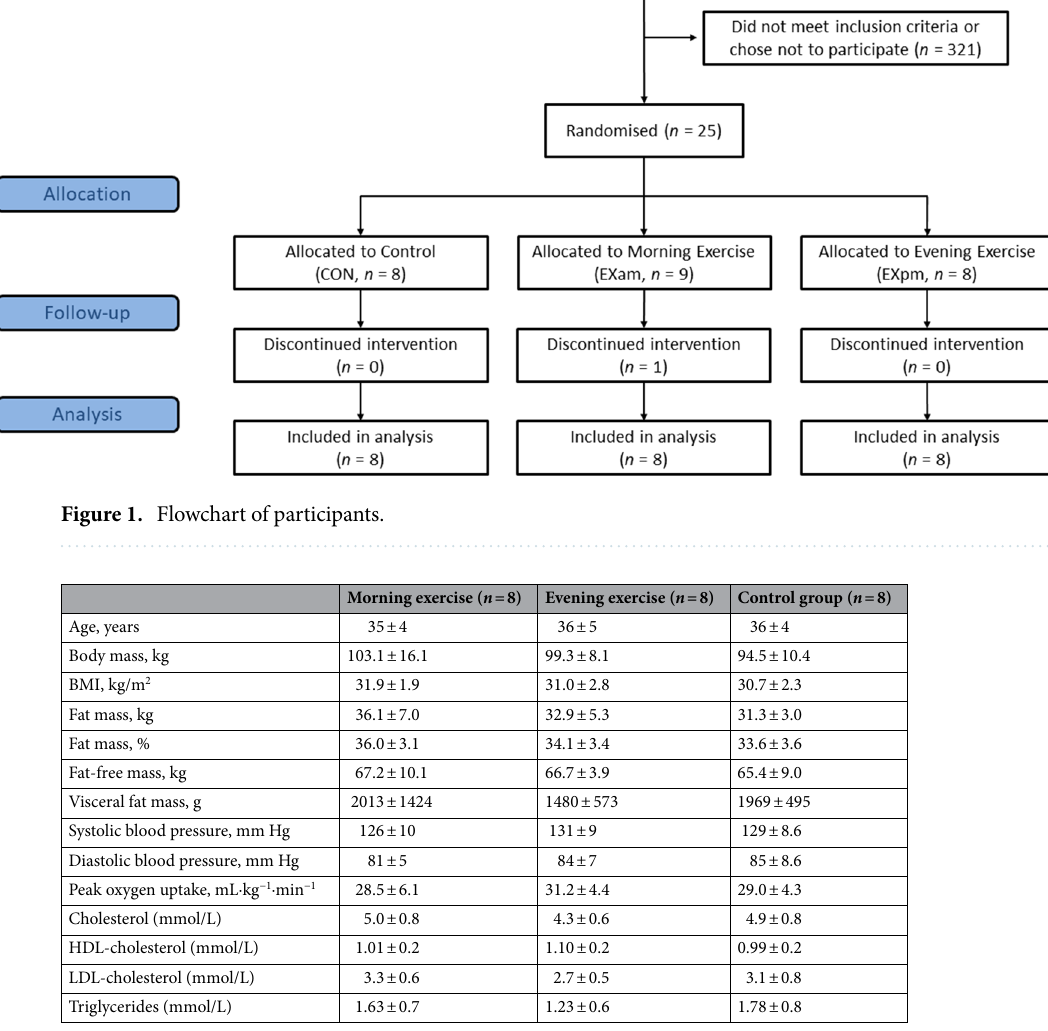
Table 1. Baseline characteristics of participants included in analyses, according to group. Lipids measured by clinical chemistry. Data are mean ±